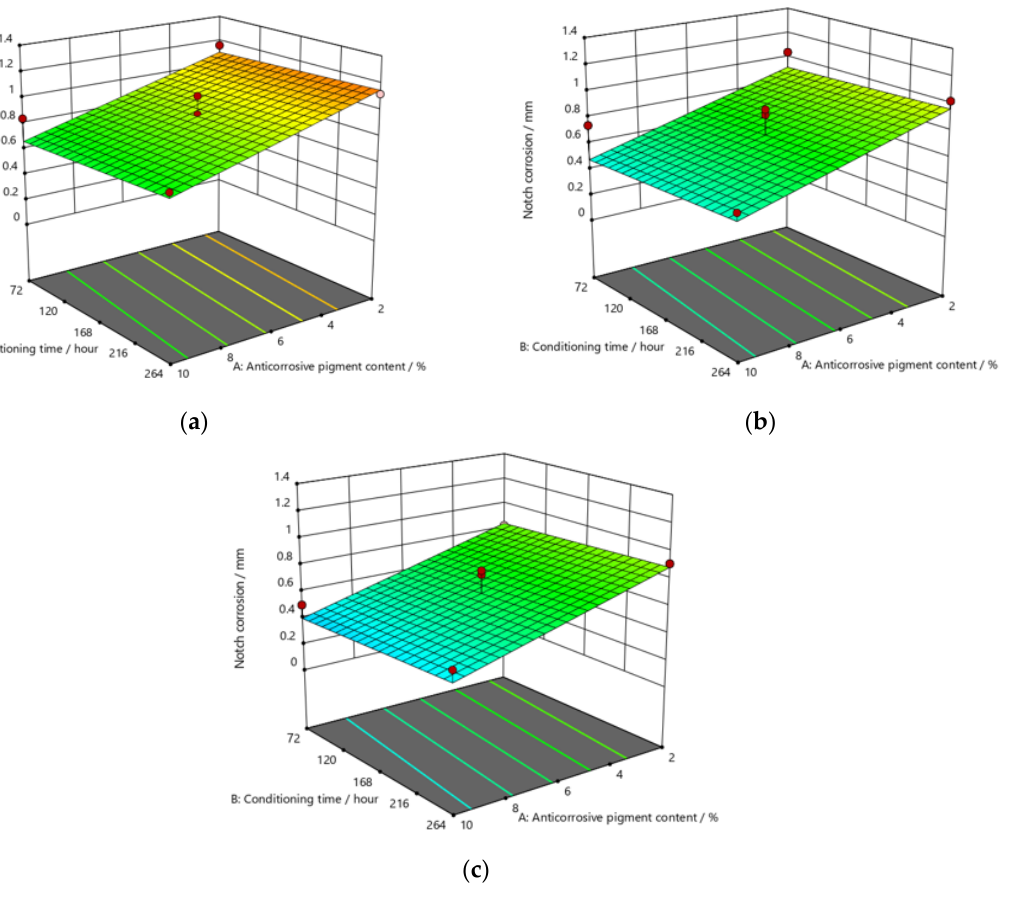
Figure 11. Response surface for regression model of notch corrosion for coating thickness of ( a ) D 1, ( b ) D 2, and ( c ) D 3 values after 480 h in the salt-spray test chamber.